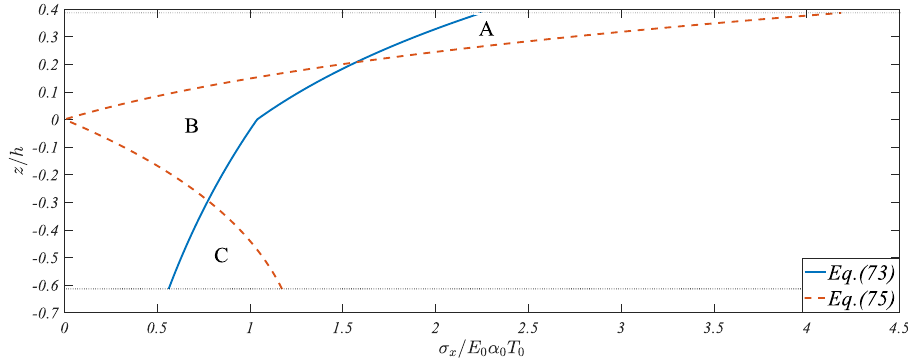
Figure 6. Axial stresses when E + ( z ) > E − ( z ), in which, a 1 = 2, a 2 = 1 and c = 1.